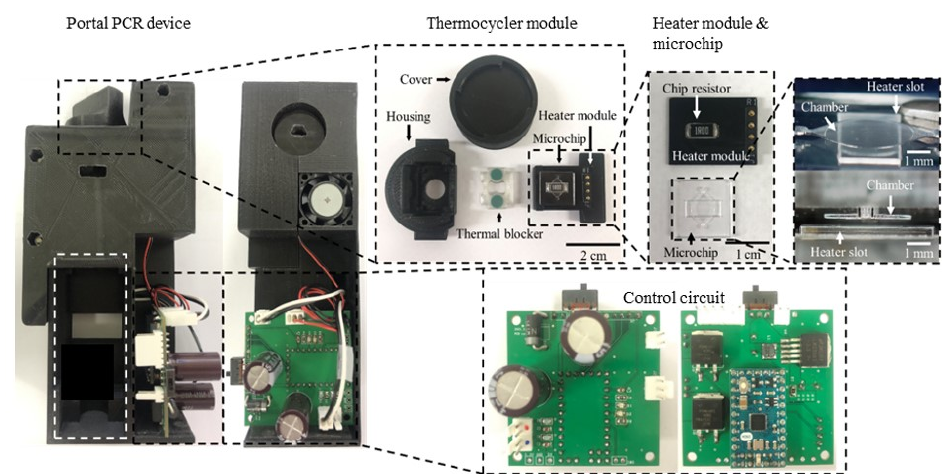
Figure 6. The fabricated PCR device. It consists of the thermocycler module and the control circuit with the MCU. The 3D glass microchip was successfully manufactured by the SLE process. The housing for enclosing all components was fabricated using a 3D